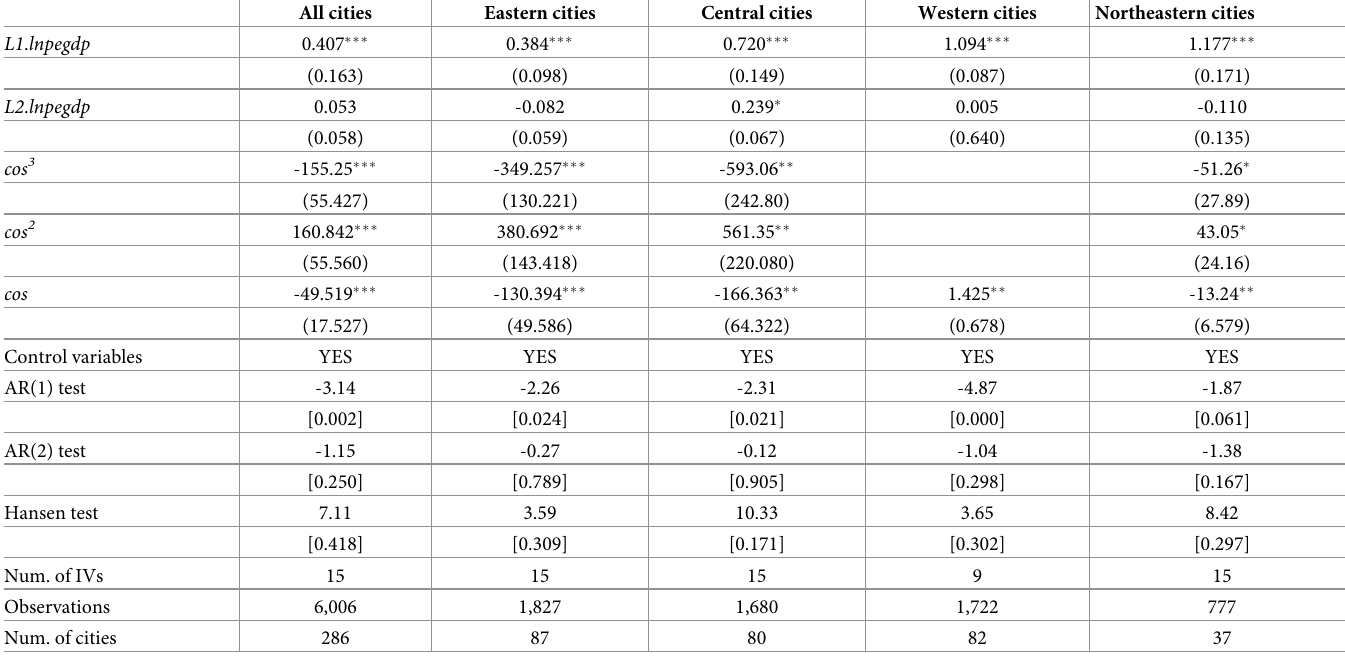
Table 5. GMM regression of Eq (38) (dependent variable: lnrpgdp ). All cities Eastern cities Central cities Western cities Northeastern